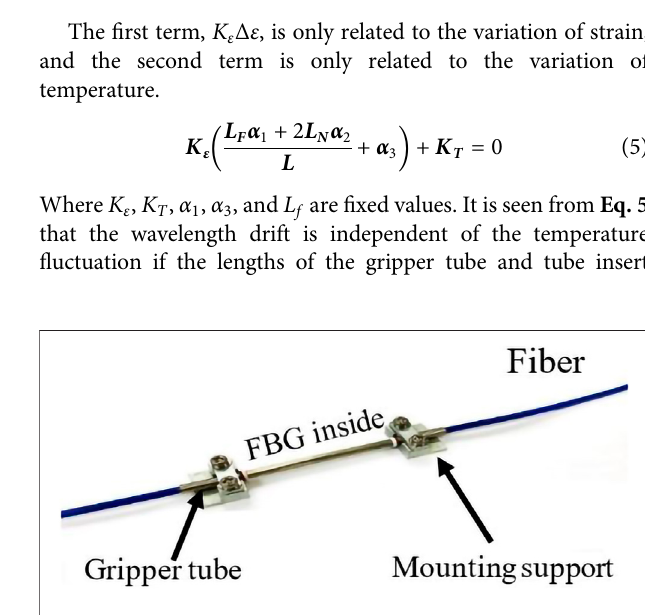
FIGURE 2 | A schematic diagram of an Fiber Bragg Grating (FBG) strain sensor packaged by gripper